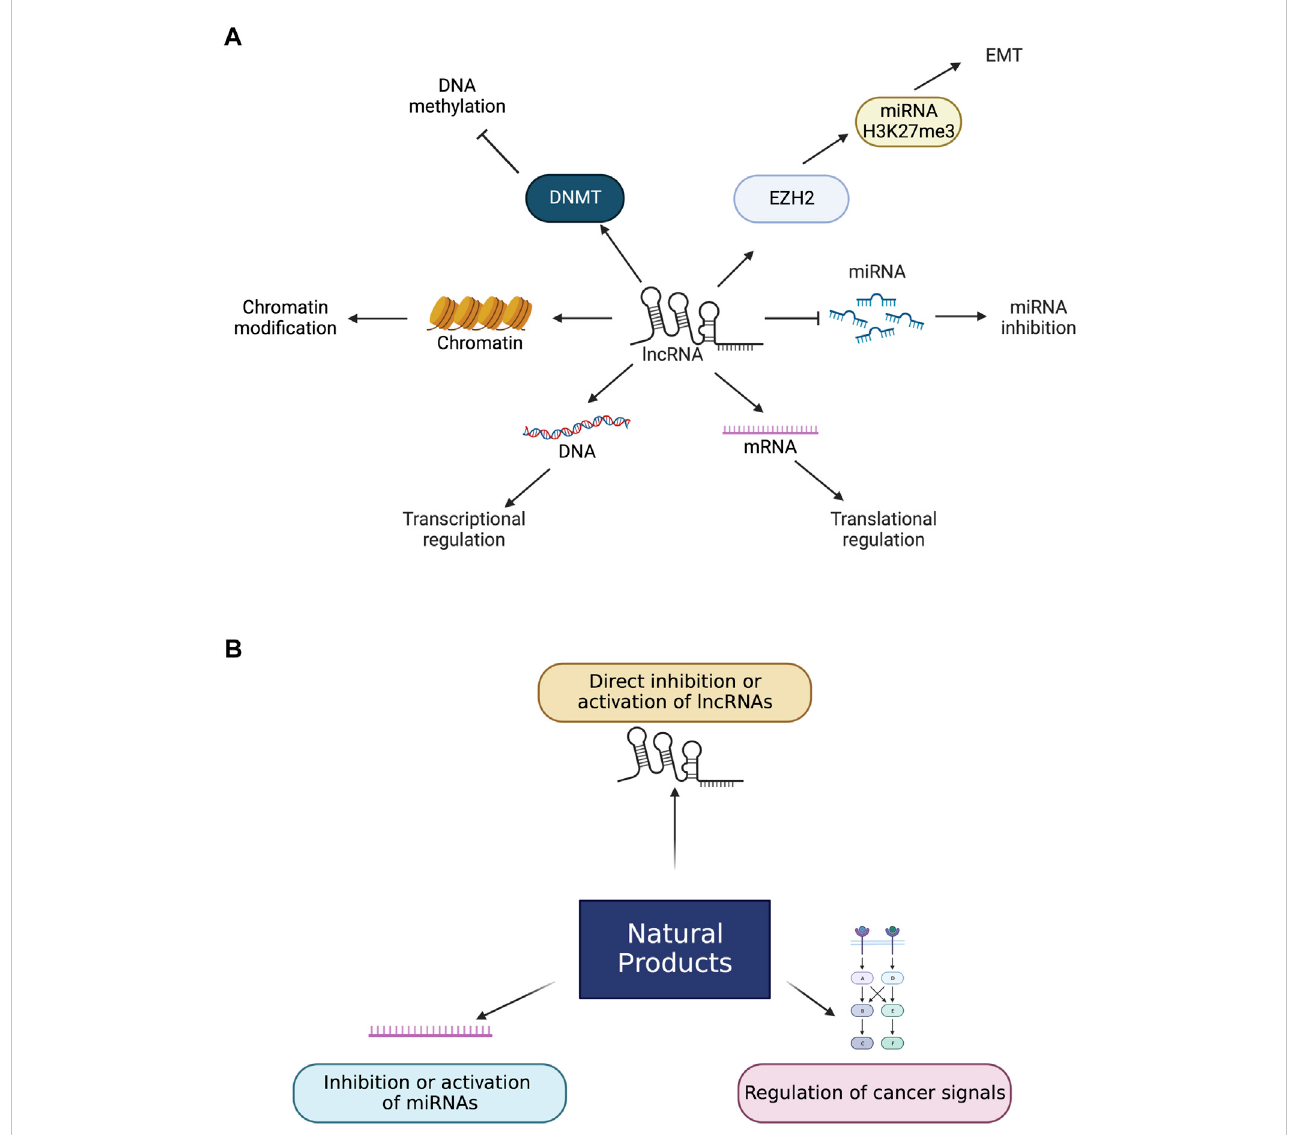
FIGURE 1 Roles of lncRNAs and natural products in cancers. (A) lncRNAs change the level of miRNAs which leads to apoptosis. miRNA inhibition can also lead to buf fi ngtheeffectofmiRNAs.LncRNAsleadtotheEMTprocessbyinteractingwithEZH2andenhancingH3K27me3levels.LncRNAscontrolthetranscriptional and translational levels by controlling DNA and mRNA directly and are involved in chromatin modi fi cation. LncRNAs bind to DNMT and suppress DNA methylation. (B) . Natural products have several biological effects on lncRNAs directly and indirectly. Natural products can directly bind to lncRNAs to